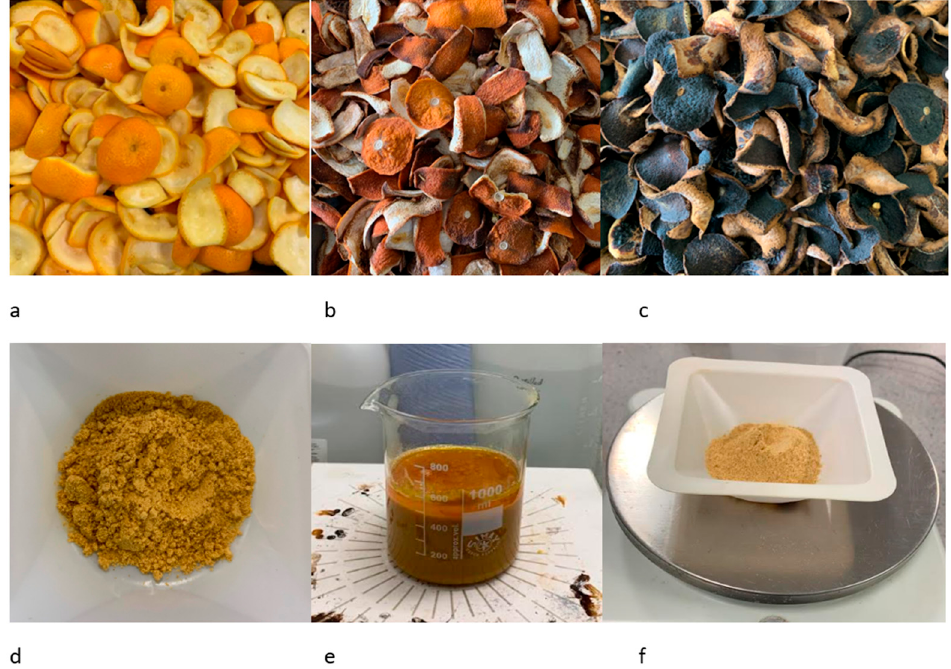
Figure 2. Different stages of orange peel adsorbent preparation: ( a ) fresh orange peels, ( b ) orange peels dried for 24 h at 75 °C, ( c ) orange peels dried for 72 h at 75 °C, ( d ) dried orange peel powder, ( e ) orange peel soaked in NaOH and ethanol solution, ( f ) chemically modified orange peel.